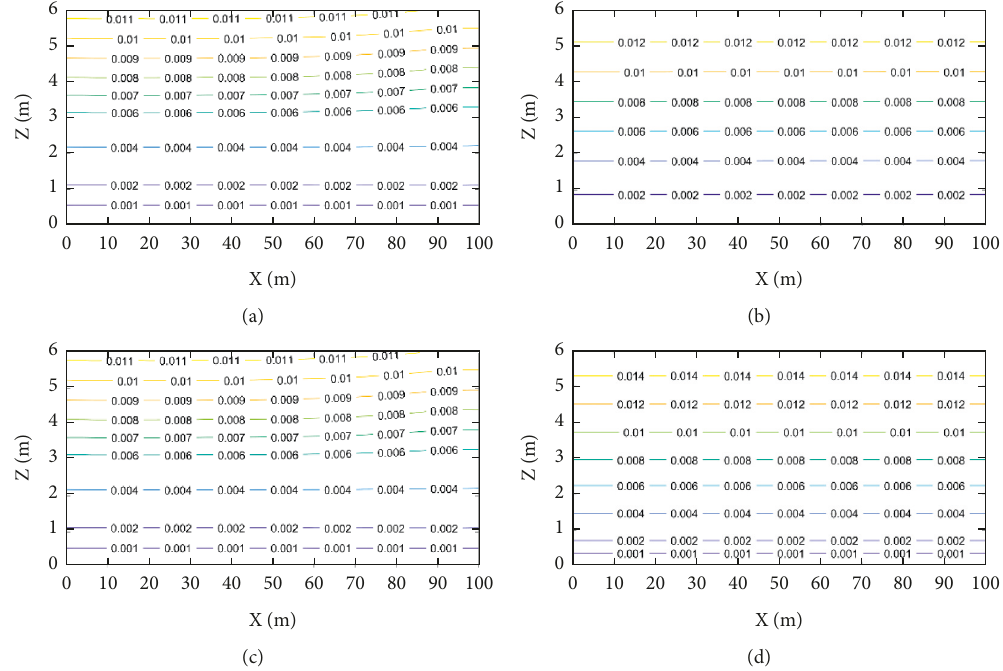
Figure 6: Isoline of coal deformation. (a) 3days, (b) 10days, (c) 20 days, and (d)